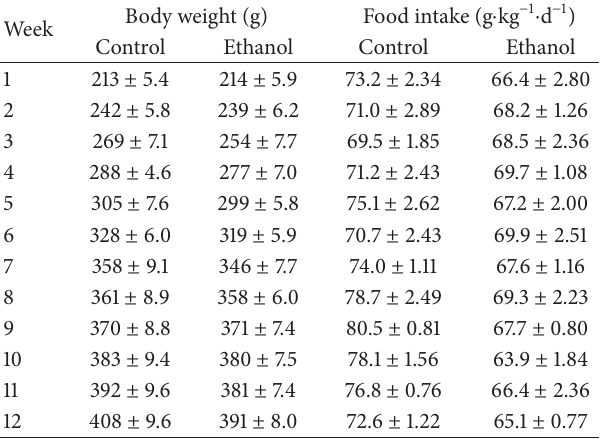
Table 1: Body weight and food intake of ethanol and control rats (mean ± SEM, 𝑛 = 20 ).